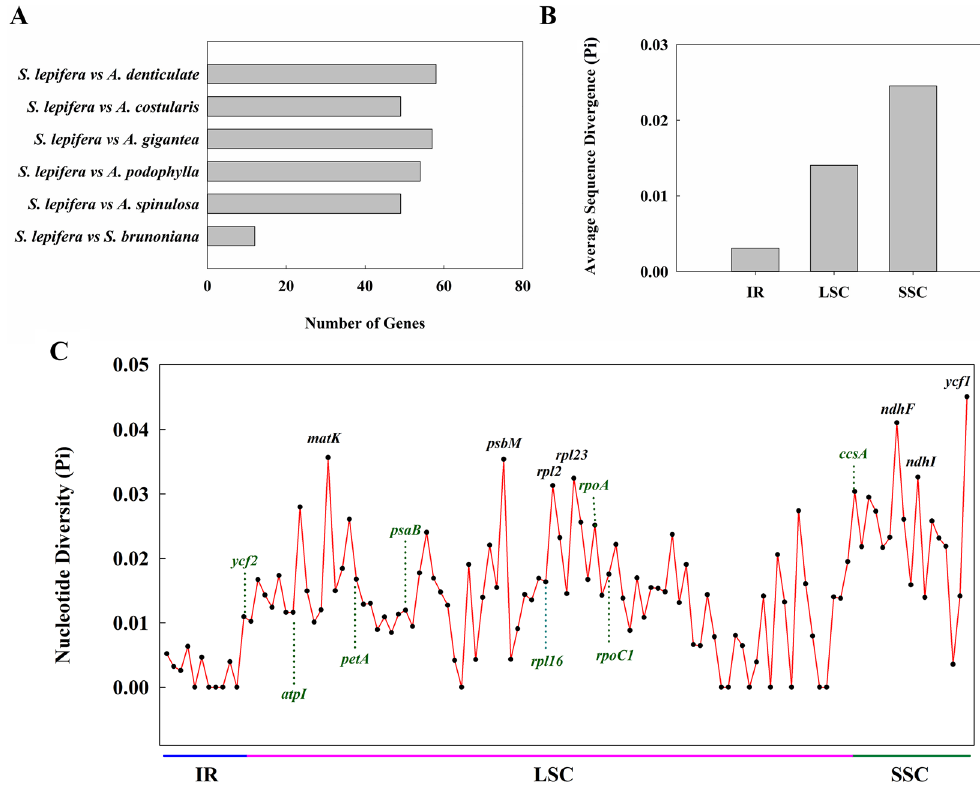
Figure 6. Nucleic acid diversity analysis. ( A ) Number of purified selective gene mutations between S. lepifera and other tree ferns. ( B ) Average nucleic acid diversity in different regions. ( C ) Nucleotide diversity analysis of